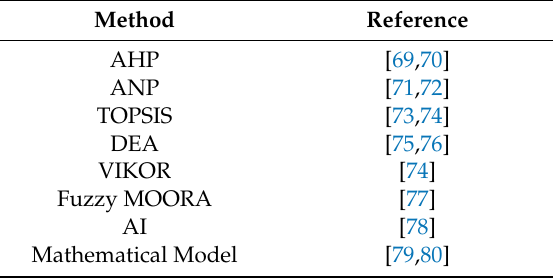
Table 2. Summary of third-party reverse logistics provider (3PRLP) selection